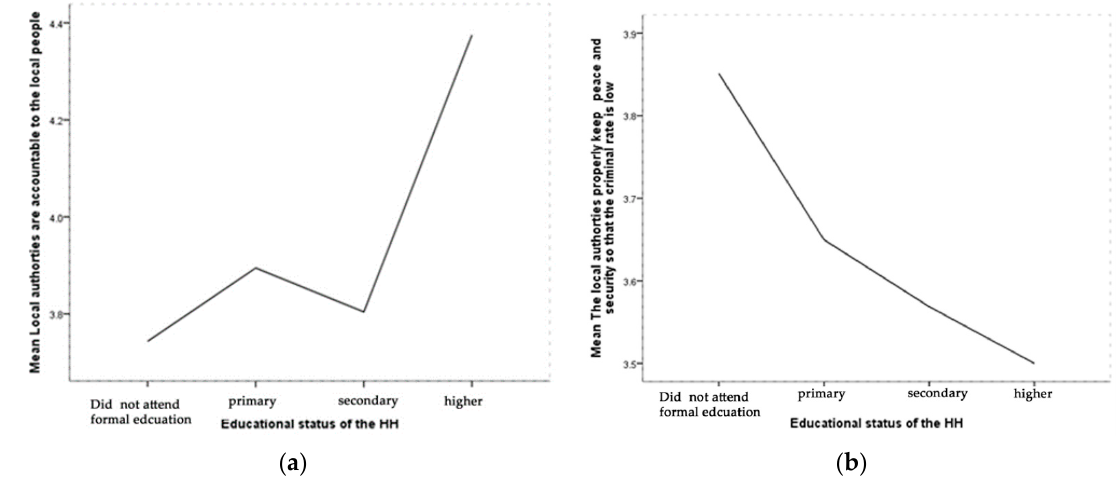
Figure 4. Households’ views of power relations based on their educational status; source: survey data by the authors (2011/12).